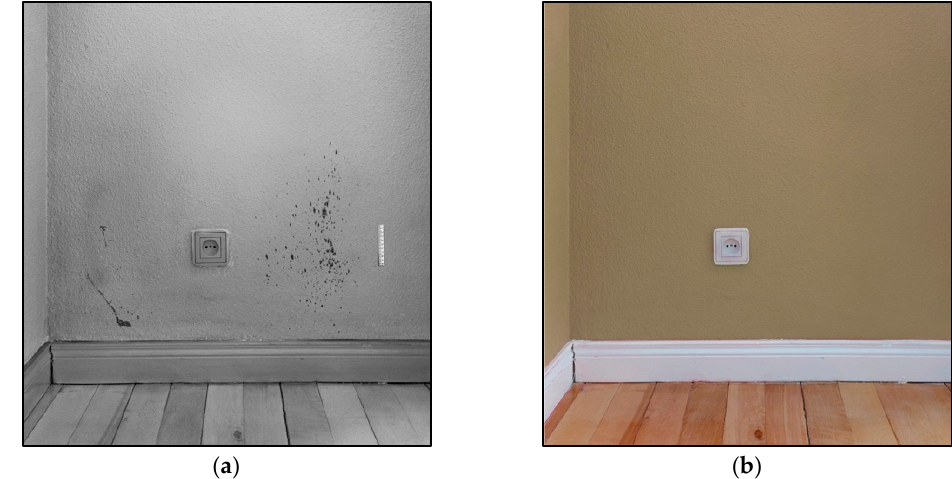
Figure 6. Images of a wall with traces of latent blood under a layer of acrylic paint: ( a ) photographed with a conventional camera and illuminated with white visible light and ( b ) by Invespector illumi- nated with IR radiation 850 nm.